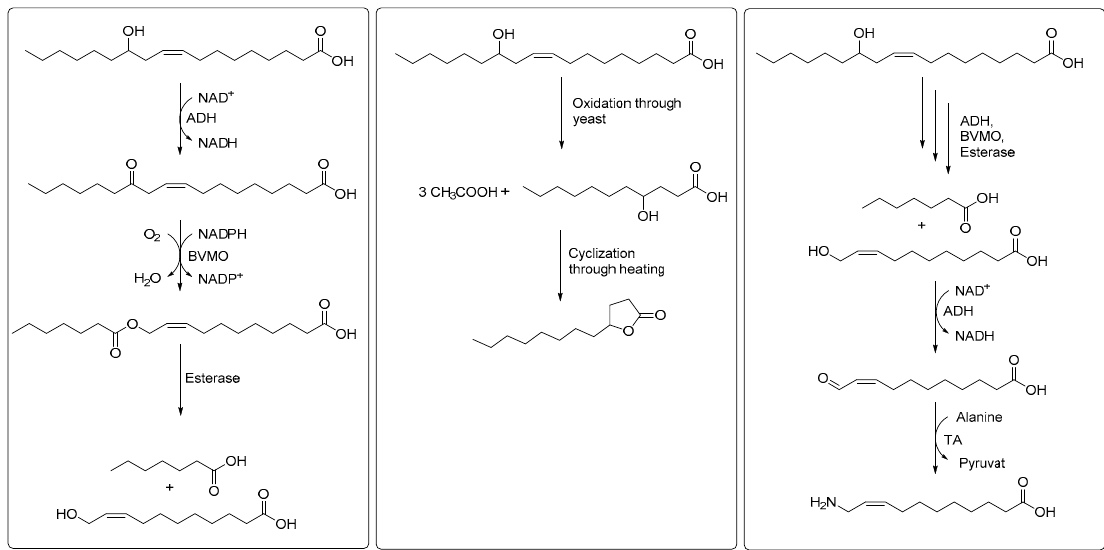
Figure 4. Chosen examples for the enzymatic cascade reactions involving fatty acid hydratases. Shown are the synthesis of ω -hydroxycarboxylic acid [67], ω -aminocarboxylic acids [68,69] and γ -lactone [2]. NAD/NADH (Nicotinamide adenine dinucleotide), ADH (Alcohol dehydrogenase), BVMO (Bayer-Villiger monooxygenase), TA (Transaminase).